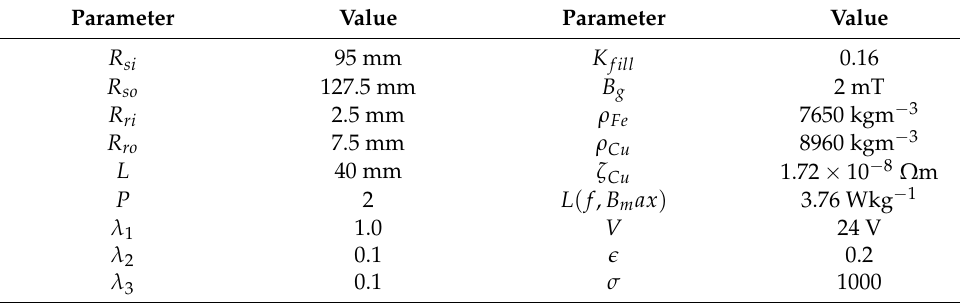
listed in Table 9. The geometric parameters and variables from the GA procedure are utilized in the simulation and gave the results shown in Figure 13 and Table 10. Table 7. List of constant parameters and their values.